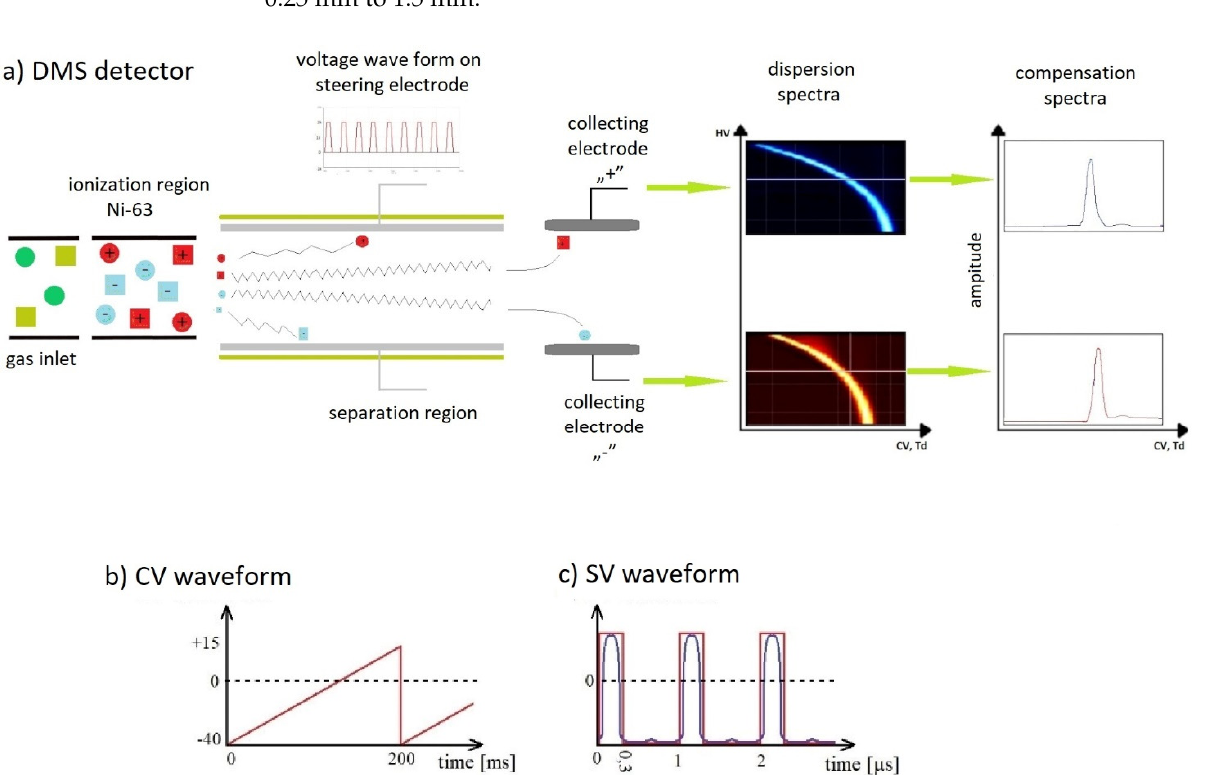
conditions (1 atm, 0 ◦ C), N 0 = 2.687 × 10 19 cm − 3 , so 1 Td corresponds to 268.7 V/cm